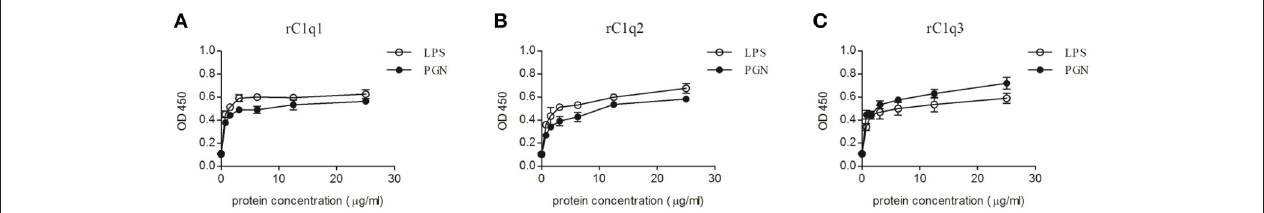
FIGURE 9 | ELISA assay that detects the binding of rC1q1, rC1q2, or rC1q3 to LPS and PGN using anti-His antiserum. The data shown are the mean ± SE obtained from three individual